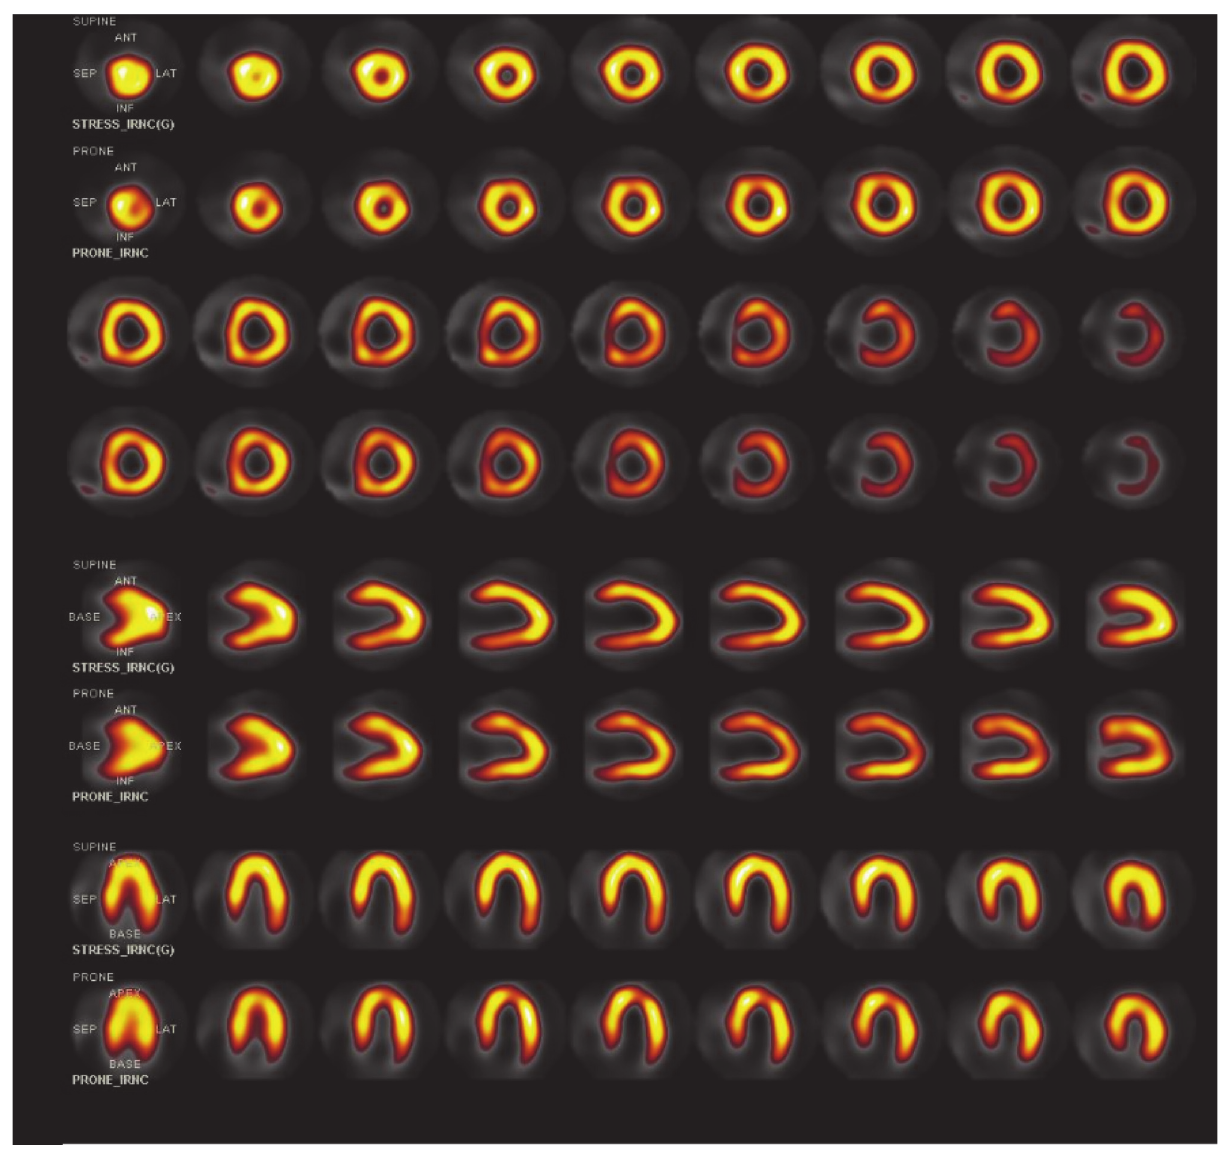
Figure 4: SPECT stress-only Tc-99m sestamibi myocardial perfusion imaging, demonstrating normal left ventricular perfusion. Short axis, vertical long axis, and horizontal long axis images, with images with patient supine displayed in odd rows and corresponding images with patient prone displayed in even